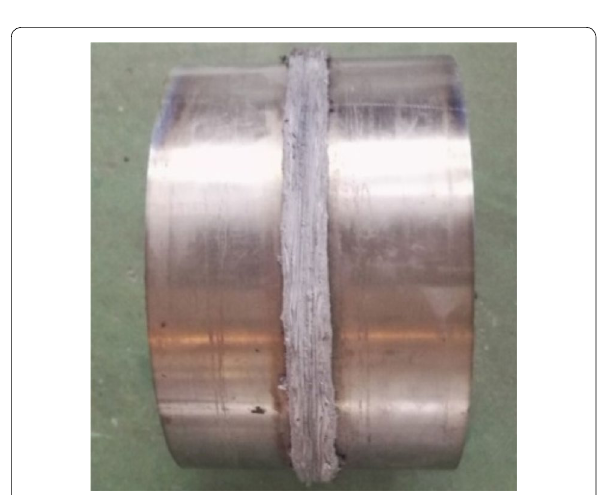
Figure 3 Appearance of the TA19 welded joint